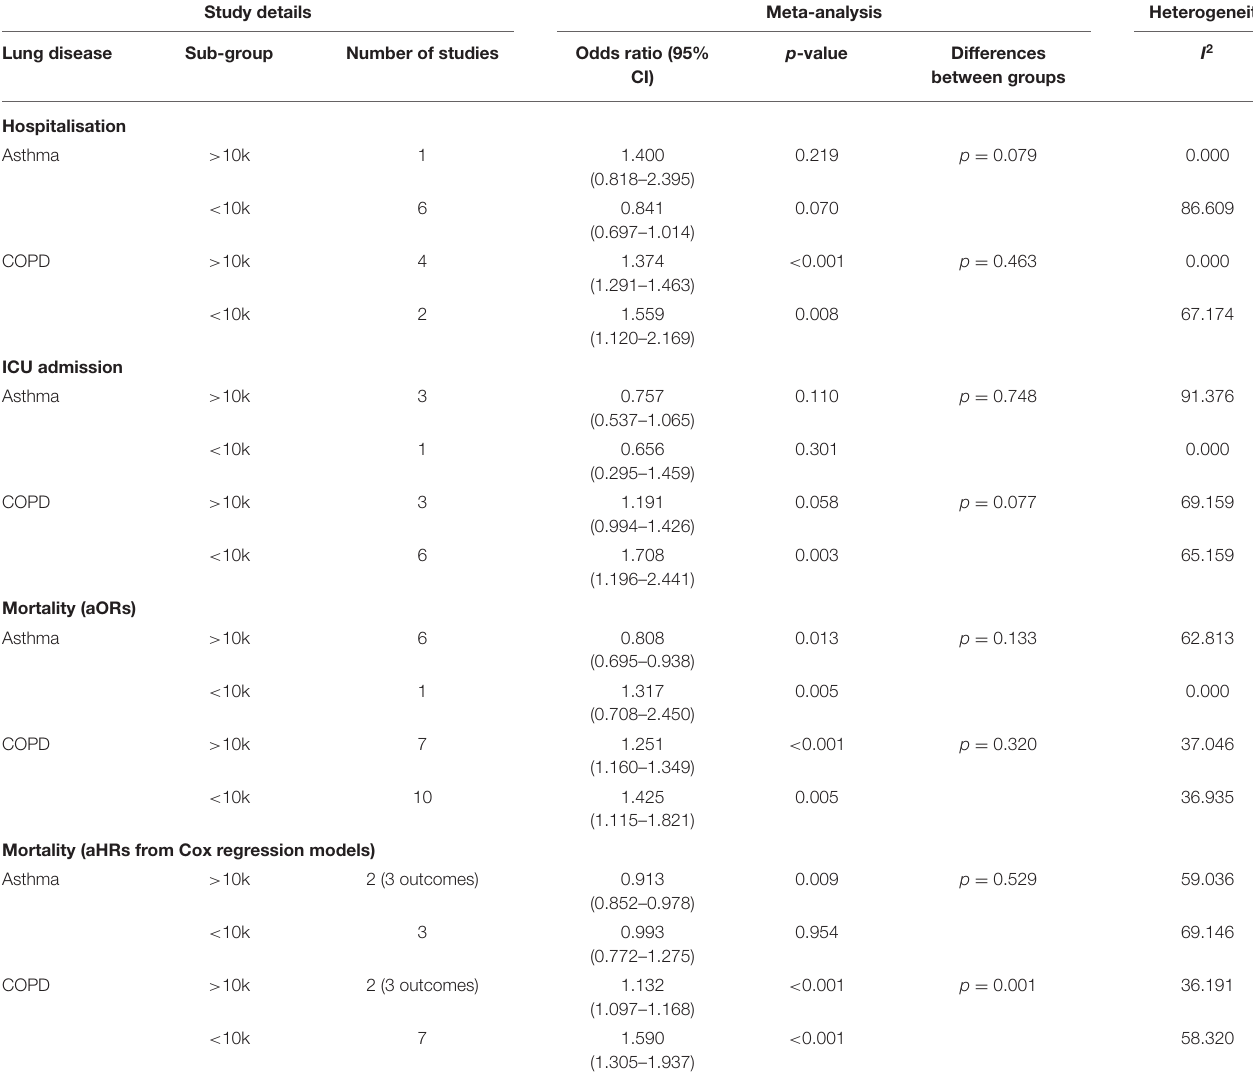
TABLE 3 | Sub-group analyses showing the pooled adjusted risk of unfavorable COVID-19 outcomes in participants with asthma or COPD stratified > 10 vs. < 10k